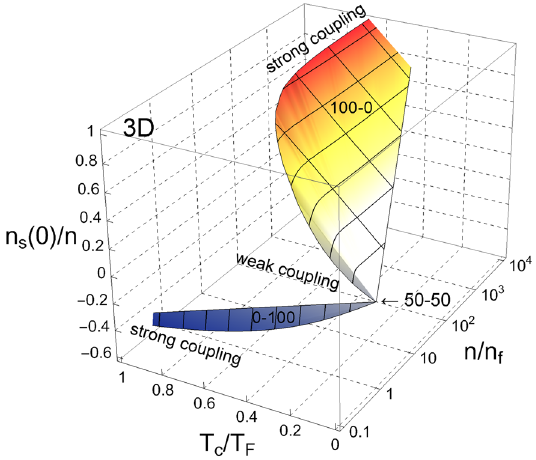
Fig. 2 Phase diagram n ∕ n f vs T c ∕ T F vs n s ( 0 )∕ n for the 100%–0% (white-red surface) and 0%–100% (light-blue surface) cases in 3D of the extended BCS-Bose crossover. The weak-coupling regime is when n ∕ n f = 1 there is a high unbound fermion density, while the strong-coupling regime occurs when n ∕ n f > 10 2 for the 100%–0% case and n ∕ n f → 1 ∕ 2 for the 0%–100% case with high boson den- sity. Note that T c ∕ T F increases linearly as the dimensionless SFD increases just as Uemura et al. [32, 33] and, independently, Božović et al. [34] found